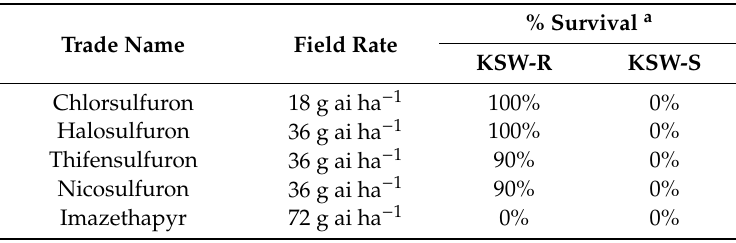
Table 3. Response of the KSW-R (resistant) and KSW-S (susceptible) wild buckwheat treated with di ff erent ALS inhibitors at their field rates at 3 weeks after